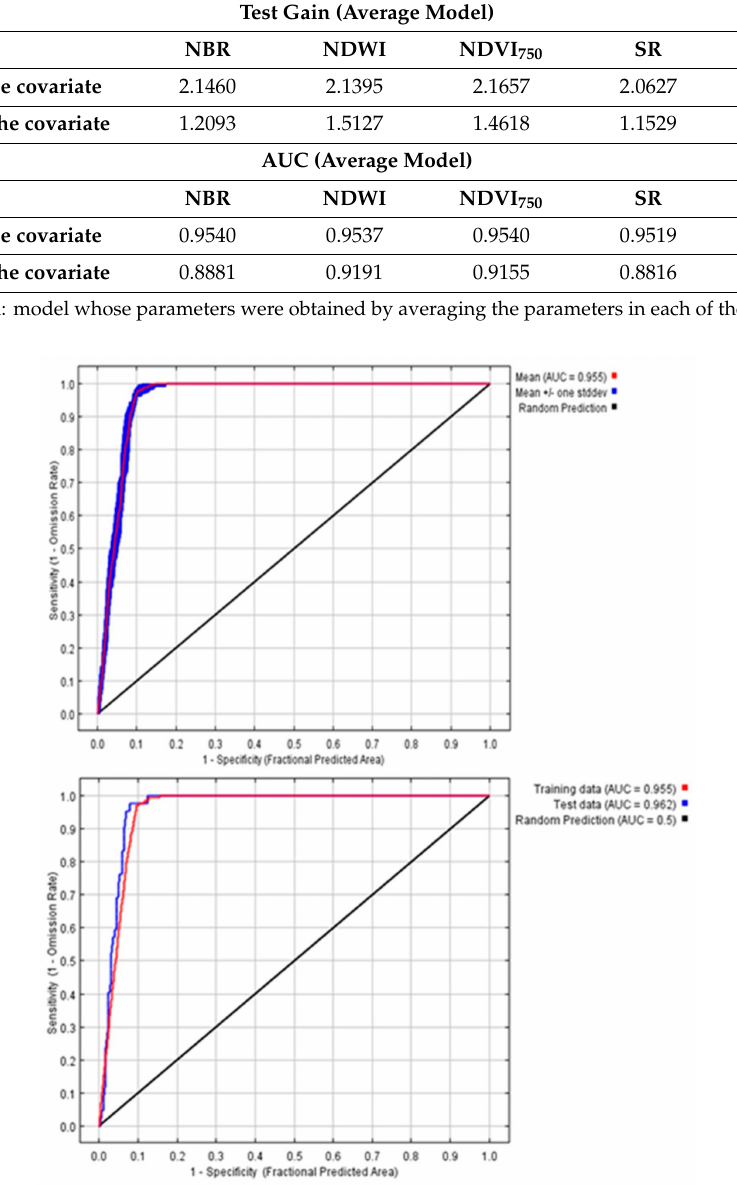
Figure 2. ROC curves. Upper: averaged model over 10 replicate runs; lower: best